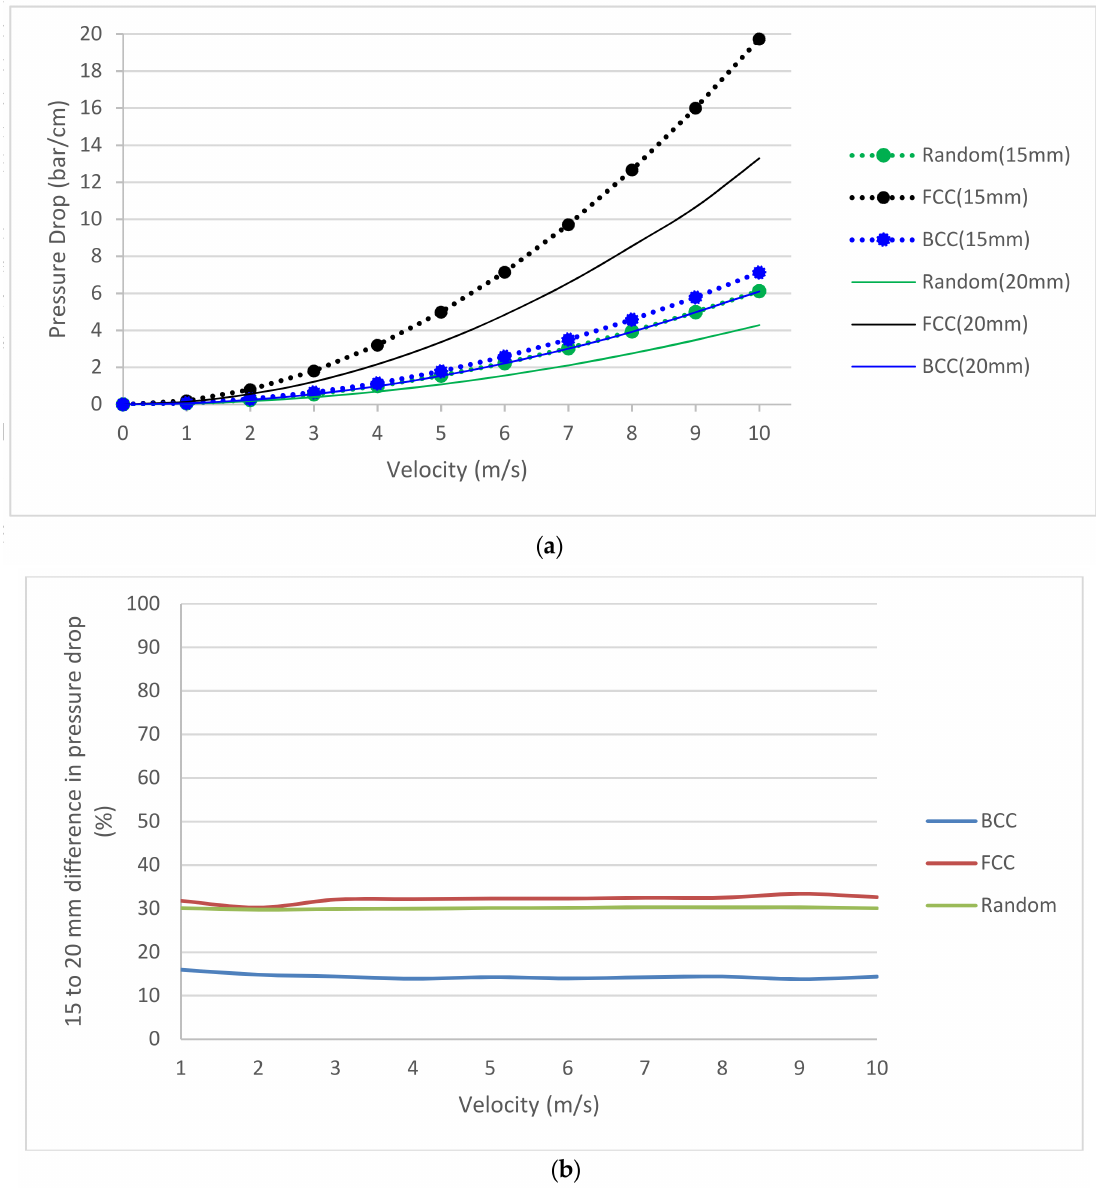
Figure 15. ( a ) Pressure drop as a function of velocity at 3 bed structures with 15 and 20 mm spheres; ( b ) Percentage difference in pressure drops as a function of